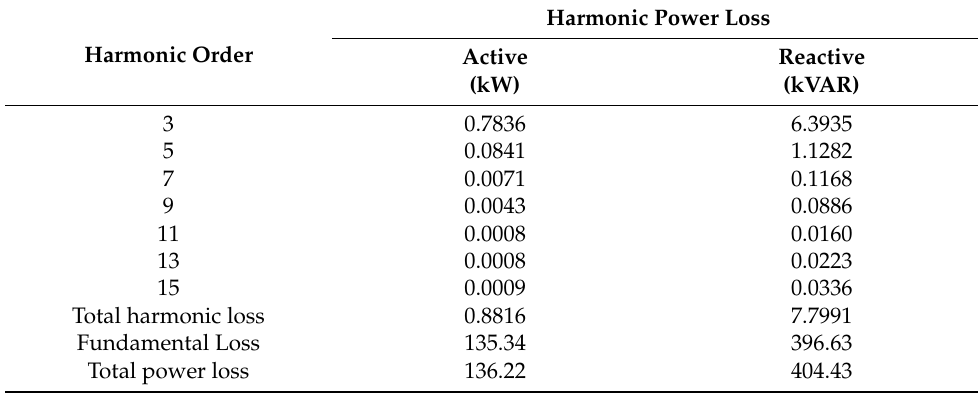
Table 8. Fundamental and Harmonic power loss for IEEE − 13 URDN with